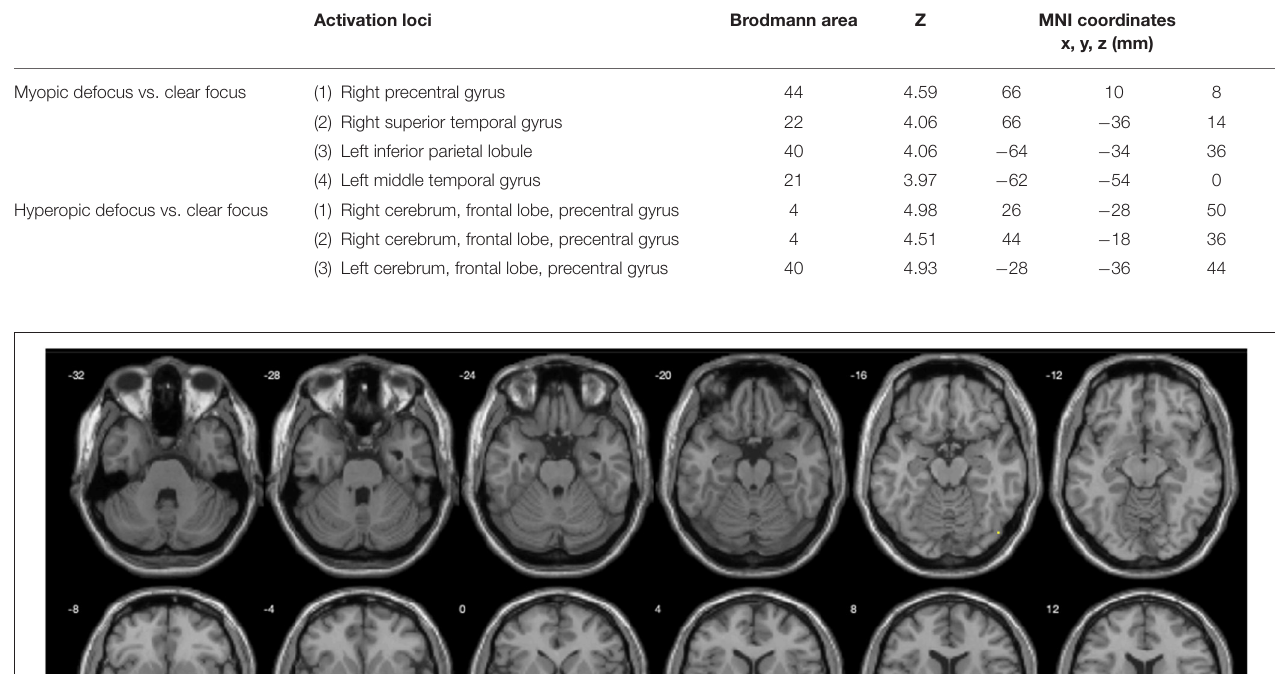
TABLE 2 | The active loci of myopic defocus and hyperopic defocus of increased regional cerebral blood flow (rCBF) response compared with clear defocus. Activation loci Brodmann area Z MNI coordinates Myopic defocus vs. clear focus